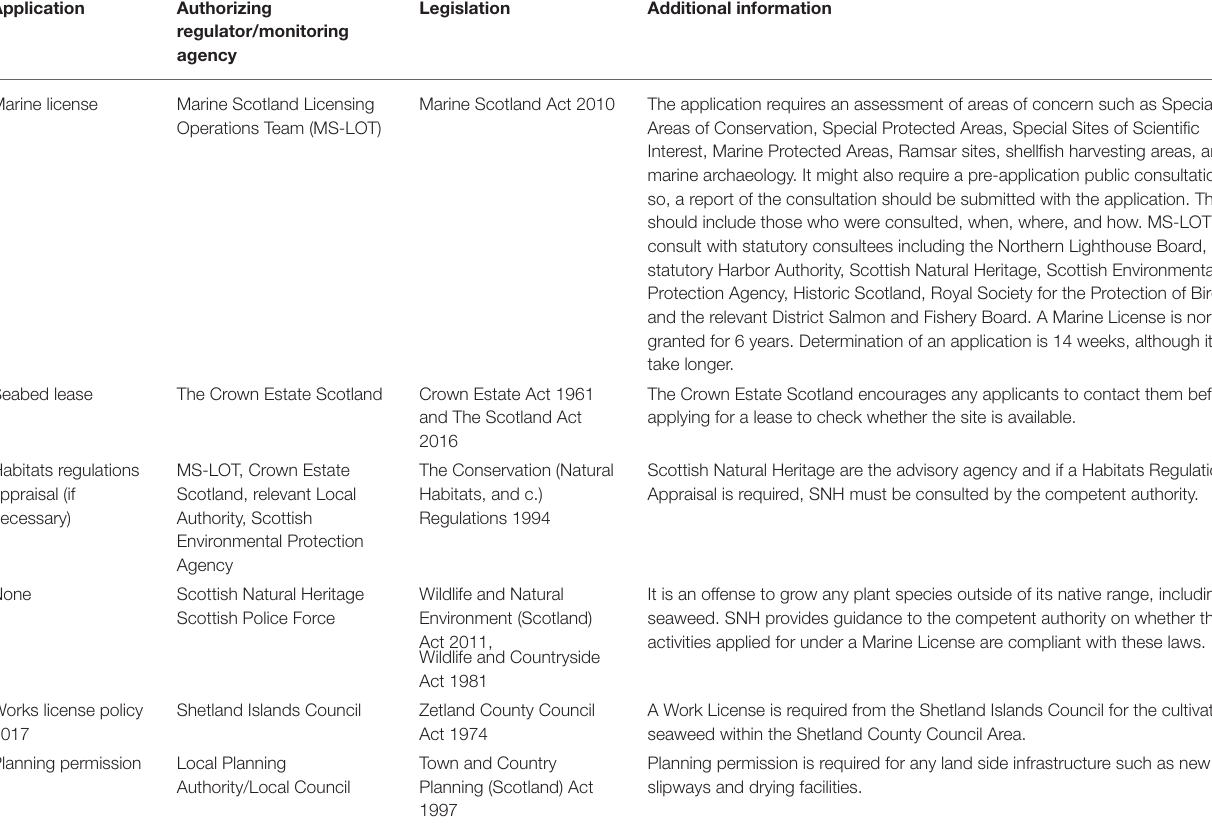
TABLE 1 | The current consenting regime for cultivating seaweed in